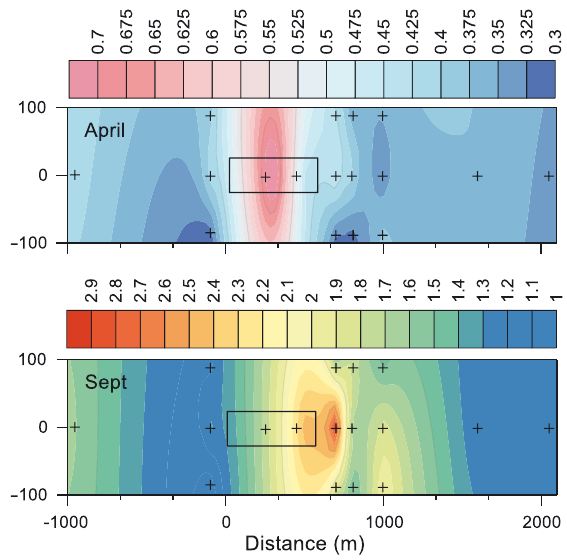
Fig. 5. Spatial distribution of the waste plume as observed with empirical measurements. Contour plots show average depth-integrated ammonium (total ammonium nitrogen in µmol l −1 ) concentrations in and around the salmon farm dur- ing sampling campaigns in April and September 2013. The rectangle represents the salmon farm (7 cages), and the crosses indicate the sampling stations (see Fig. 1C,D). The contours were interpolated using the kriging method (Surfer, V11 Golden Software). The legends specify ammo- nium concentrations for the graph immediately below. Note that the color scalings are different in the 2 plots